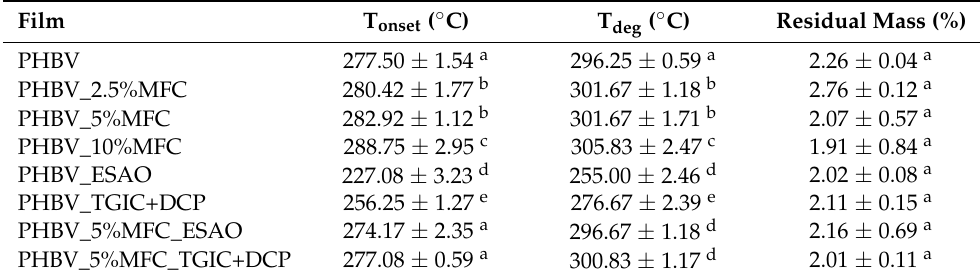
Table 4. Thermal properties obtained by thermogravimetric analysis (TGA) of the films of poly(3- hydroxybutyrate- co -3-hydroxyvalerate) (PHBV) with microfibrillated cellulose (MFC) and compatibi- lized with epoxy-based styrene-acrylic oligomer (ESAO) and with triglycidyl isocyanurate (TGIC) and dicumyl peroxide